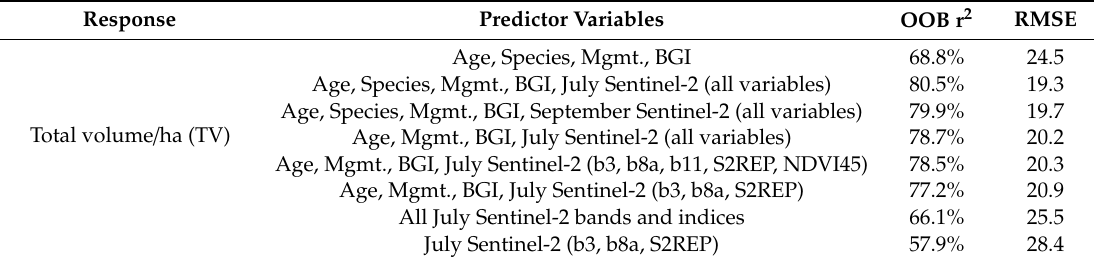
Table 3. Results of total volume (m 3 / ha) (TV) prediction by Random Forest using species composition, age, management type, BGI and Sentinel-2 spectral bands and indices.